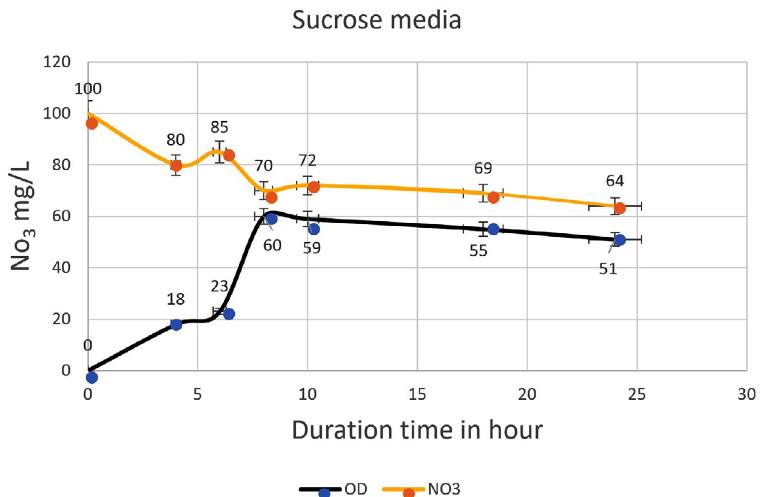
Fig. 3. The nitrate was reduced by Pseudomonas aeruginosa on mineral media with sucrose. The higher reduction of nitrate was reached after 24 h (64 mg/L). The bottom line shows the bacterial growth phase, and the top line shows the denitrification process starting from 100mg/L. The inverse relationship shows the duration of time from 0 to10 h. The direct relationship was started from 10h when bacteria began in the death